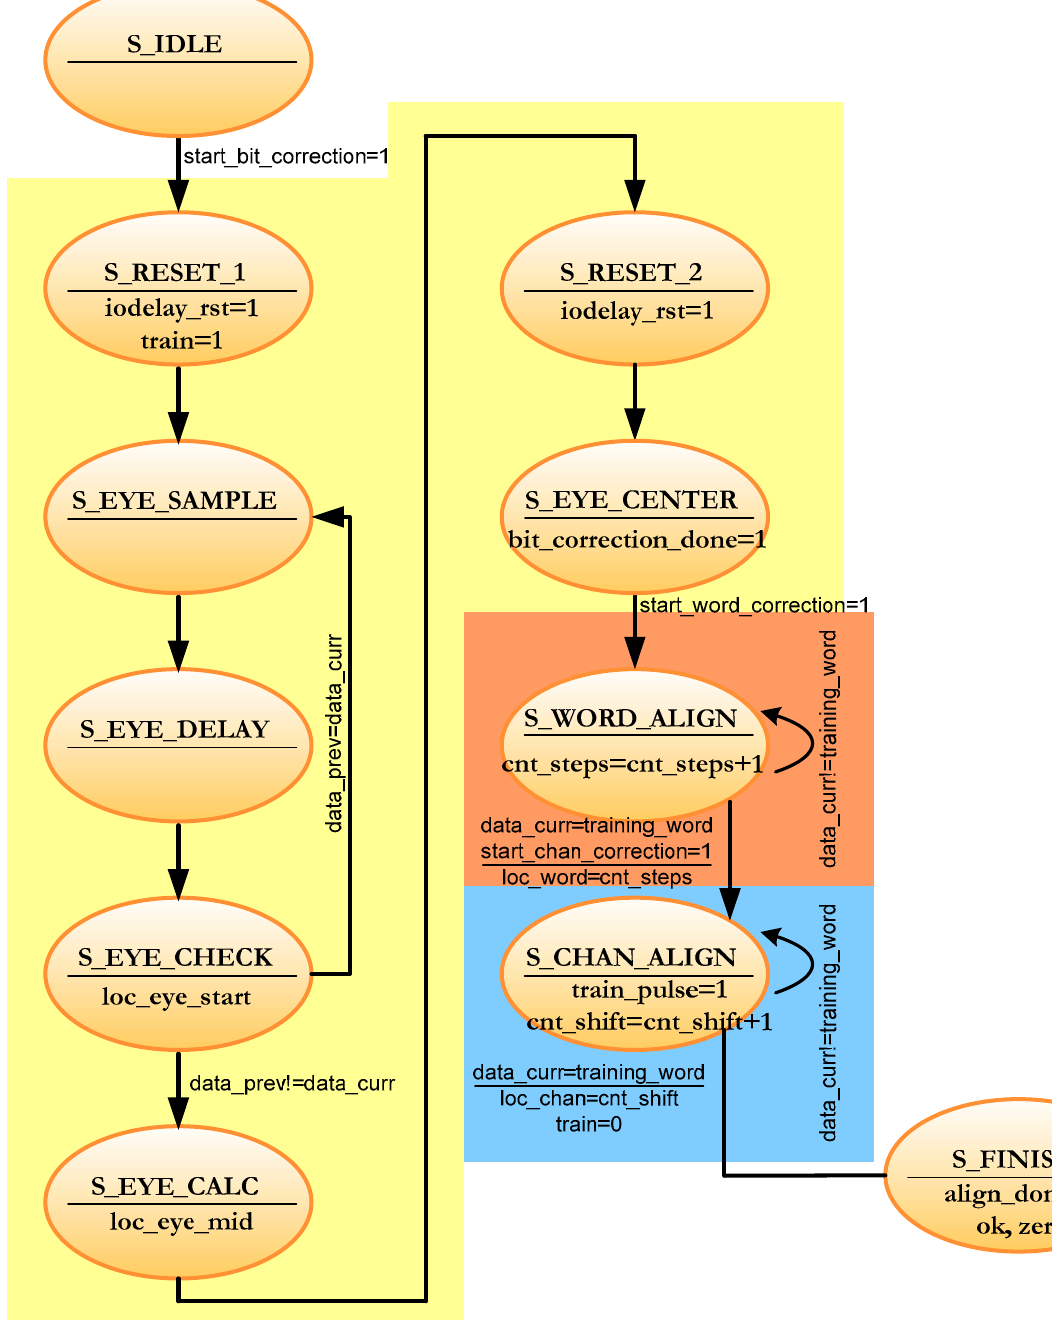
Figure 12. Simplified FSM for one channel calibration in the concurrent architecture. Table 1. Port description of training_one_channel.v module.